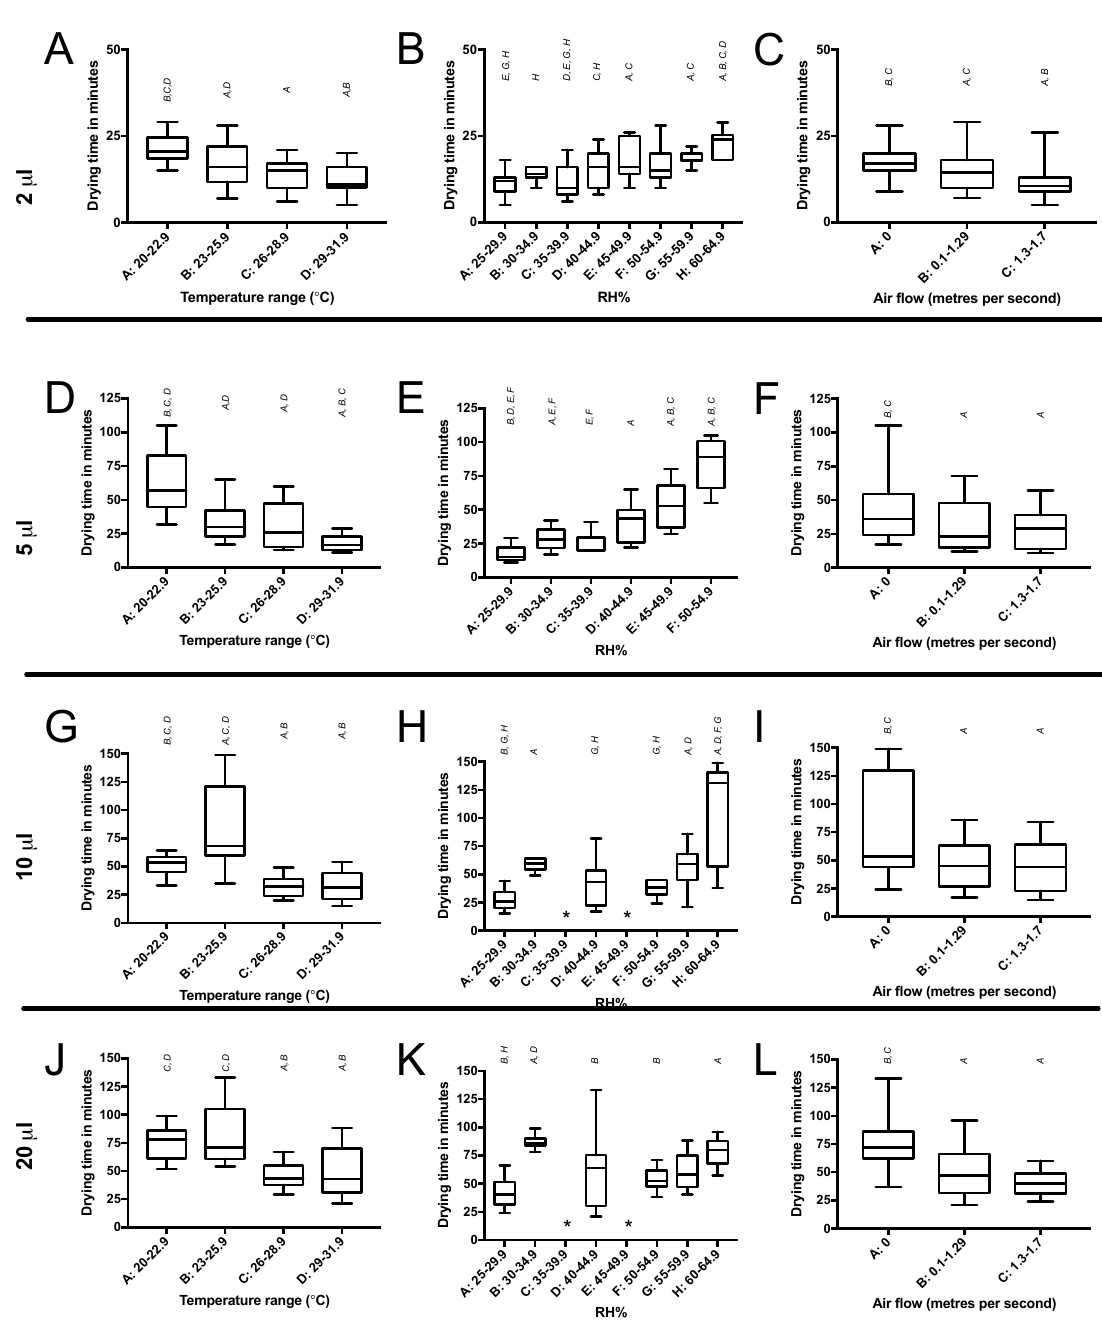
Figure 4. Drying time of either 2 µ L ( A – C ), 5 µ L ( D – F ), 10 µ L ( G – I ) or 20 µ L ( J – L ) droplets of water on plastic (polypropylene). The first graph in each row represents drying time related to temperature ( ◦ C). The second graph in each row represents drying time related to RH%. The third graph in each row represents drying time related to airflow (m/s). Vertical letters denote with which columns a statistical significance is shared ( p < 0.05). Asterix denotes a category with zero